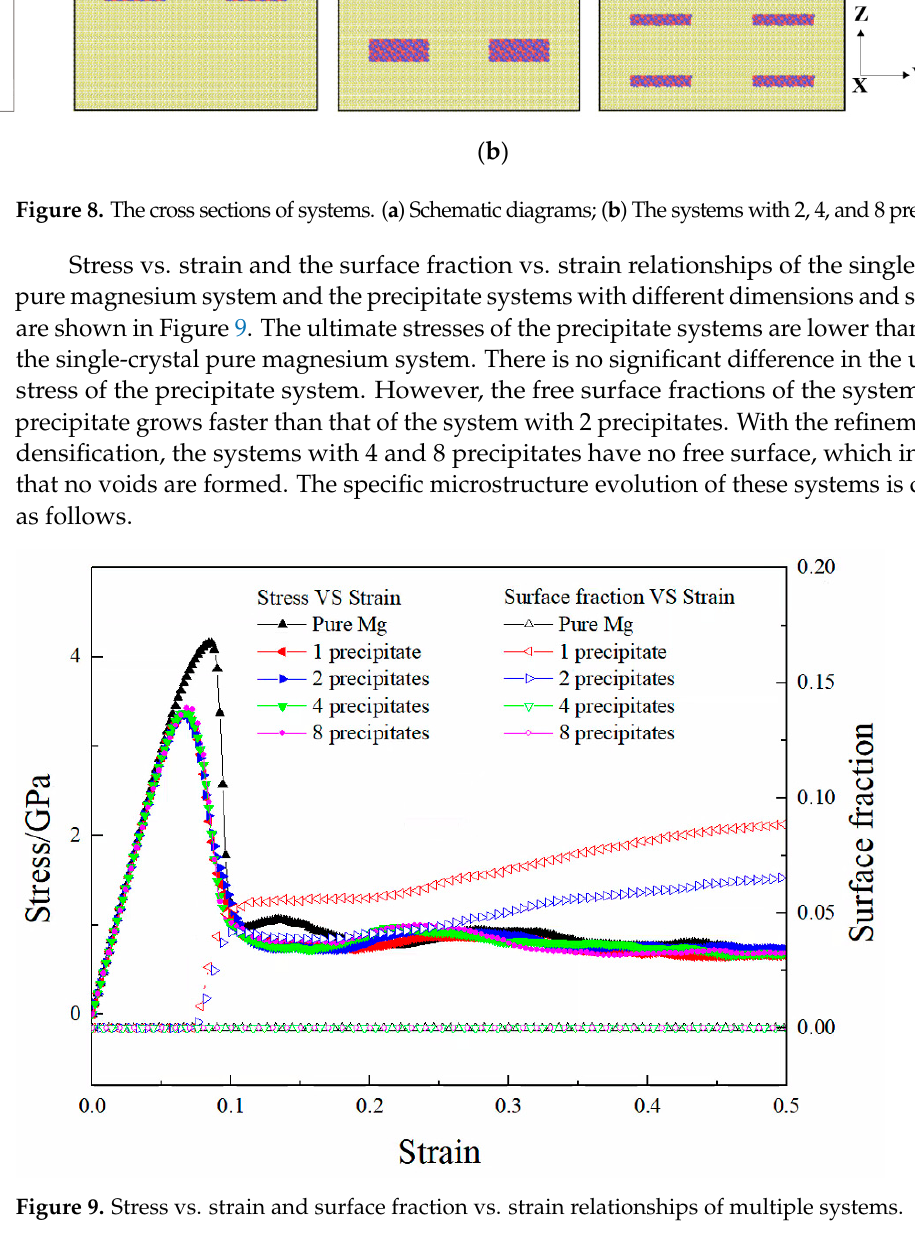
Figure 7. Comparisons of ultimate stress and free surface fraction growth among the three sys- tems.